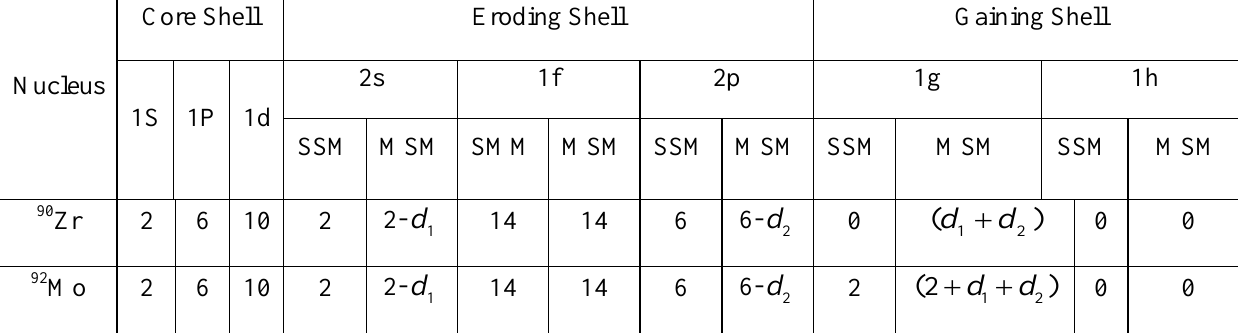
Table 2: Proton configuration of the nucleiSSSM, simple shell model; MSM, modified shell model.